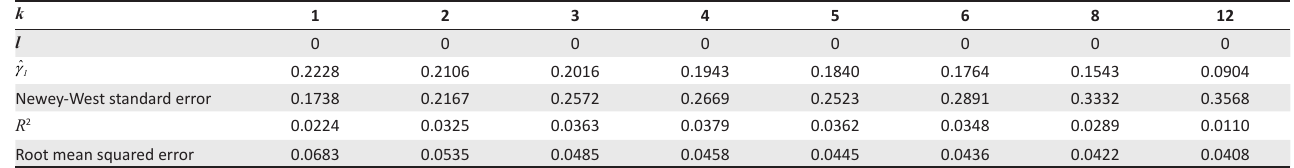
TABLE 3: Summary of results for the linear models of inflation using the RYG